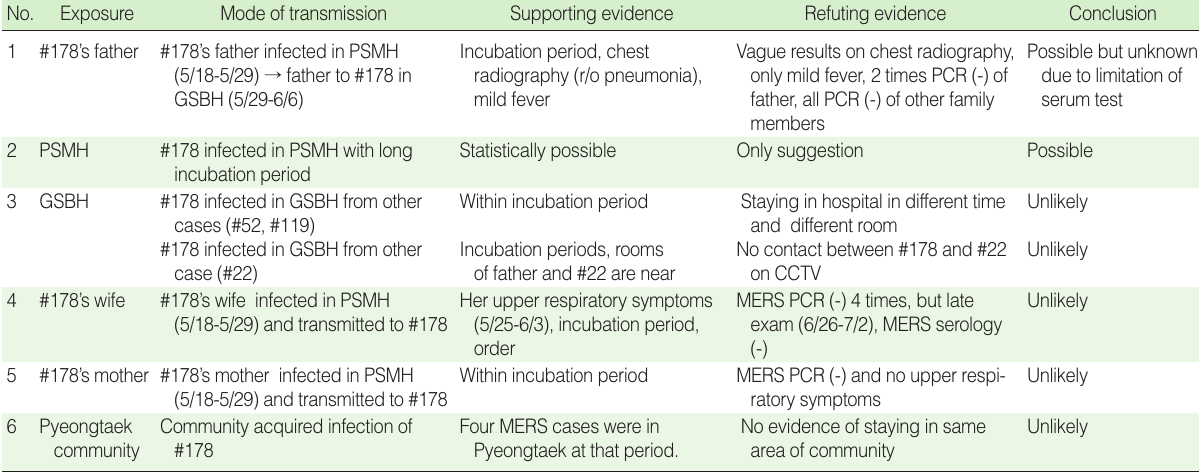
Table 1. The possible modes of transmission by exposure for the 178th MERS case No. Exposure